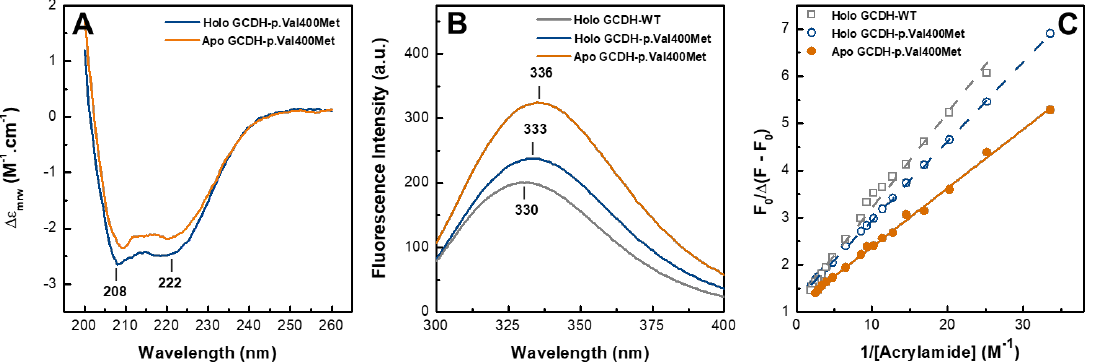
Figure 2. Spectroscopic analysis of holo and apo GCDH-p.Val400Met. ( A ) Far-UV circular dichroism (CD), ( B ) tryptophan emission, and ( C ) modified Stern–Volmer plot. In all panels GCDH-p.Val400Met holoprotein—blue line and open circle, GCDH-p.Val400Met apoprotein—orange line and closed circle, and WT—grey line and open squares. Protein concentration was 0.25 and 0.05 mg · mL − 1 , respectively, for far-UV CD and fluorescence emission spectra in 5 mM HEPES pH 7.8. Tryptophan emission spectra for GCDH-p.Val400Met holoprotein and WT were redrawn from [23] for comparison.